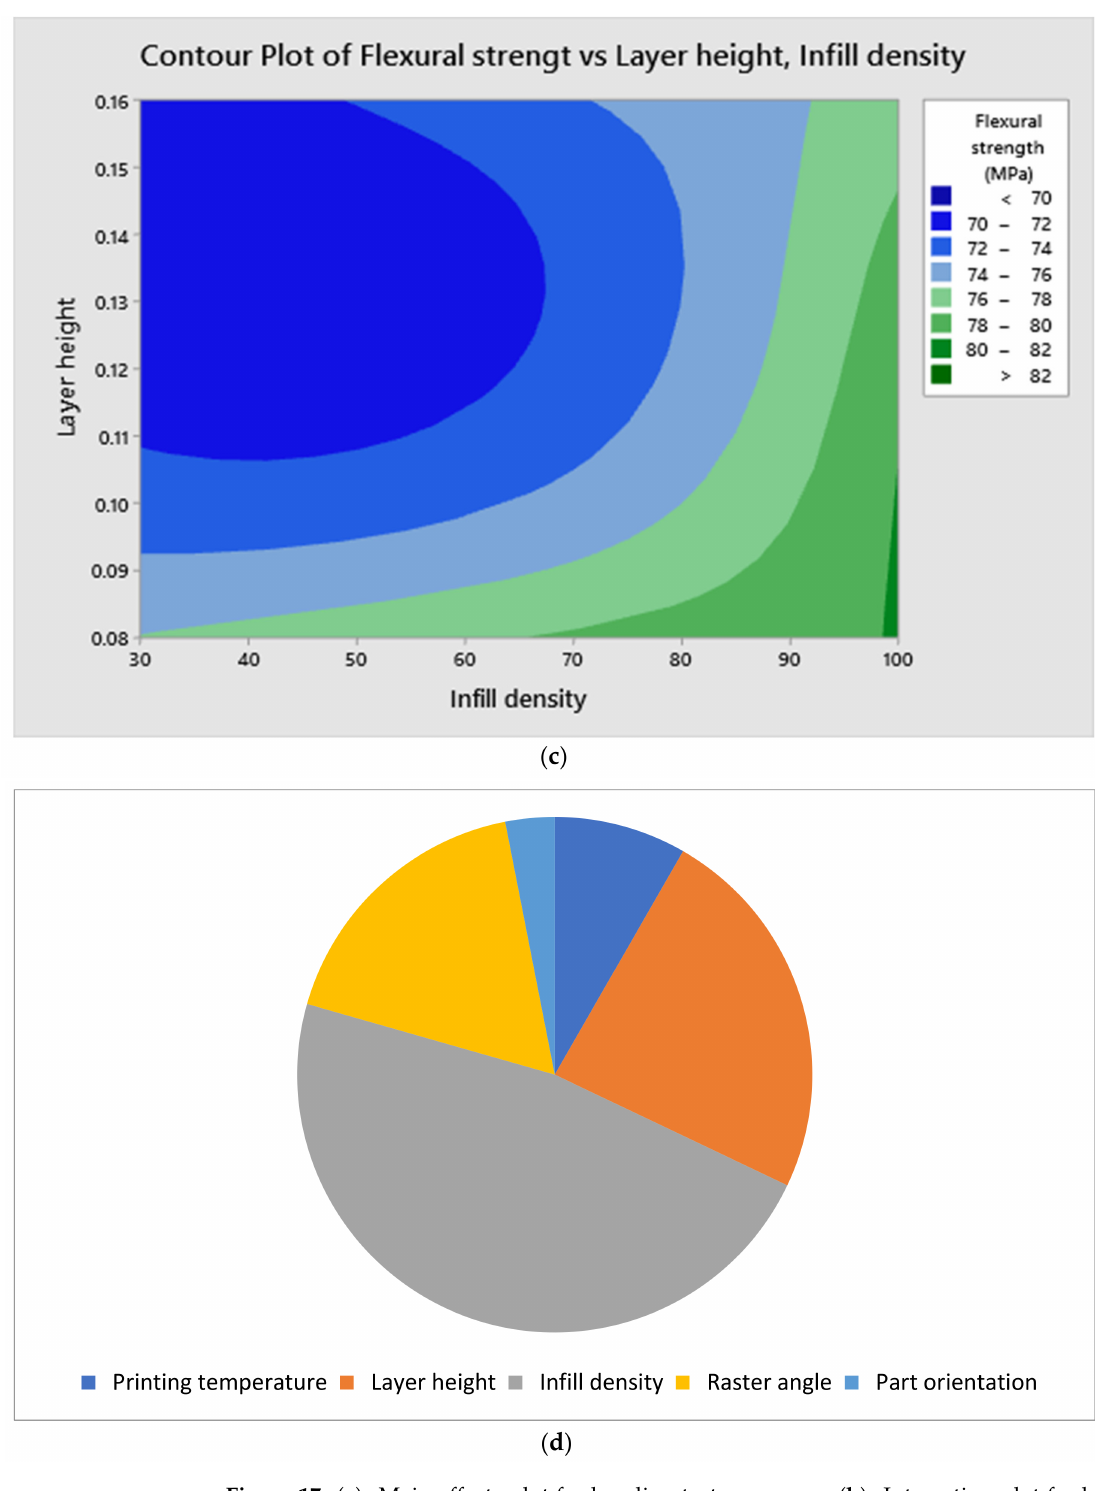
Figure 17. ( a ). Main effects plot for bending test responses. ( b ). Interaction plot for bending test responses. ( c ). Contour plot for maximum flexural strength. ( d ). Contribution of each factor for maximum flexural